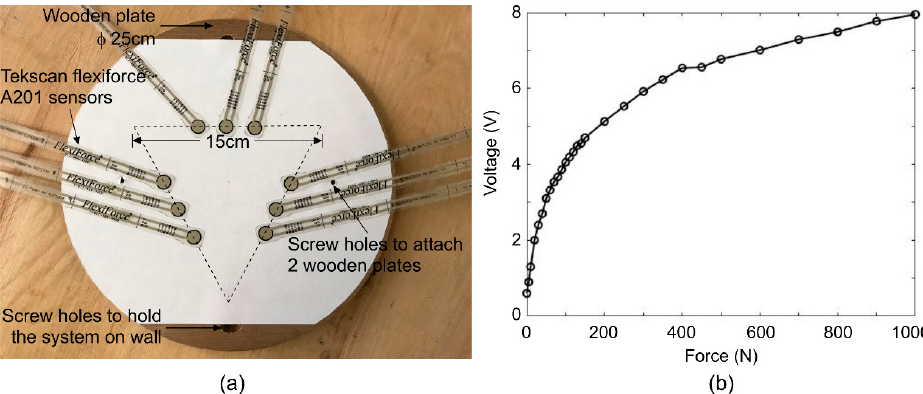
Figure 1. ( a ) The nine A201 Flexiforce sensors arranged along the sides of an equilateral triangle with a length 15 cm, ( b ) The calibration curve obtained by the Instron machine loading force on the system versus the voltage obtained.